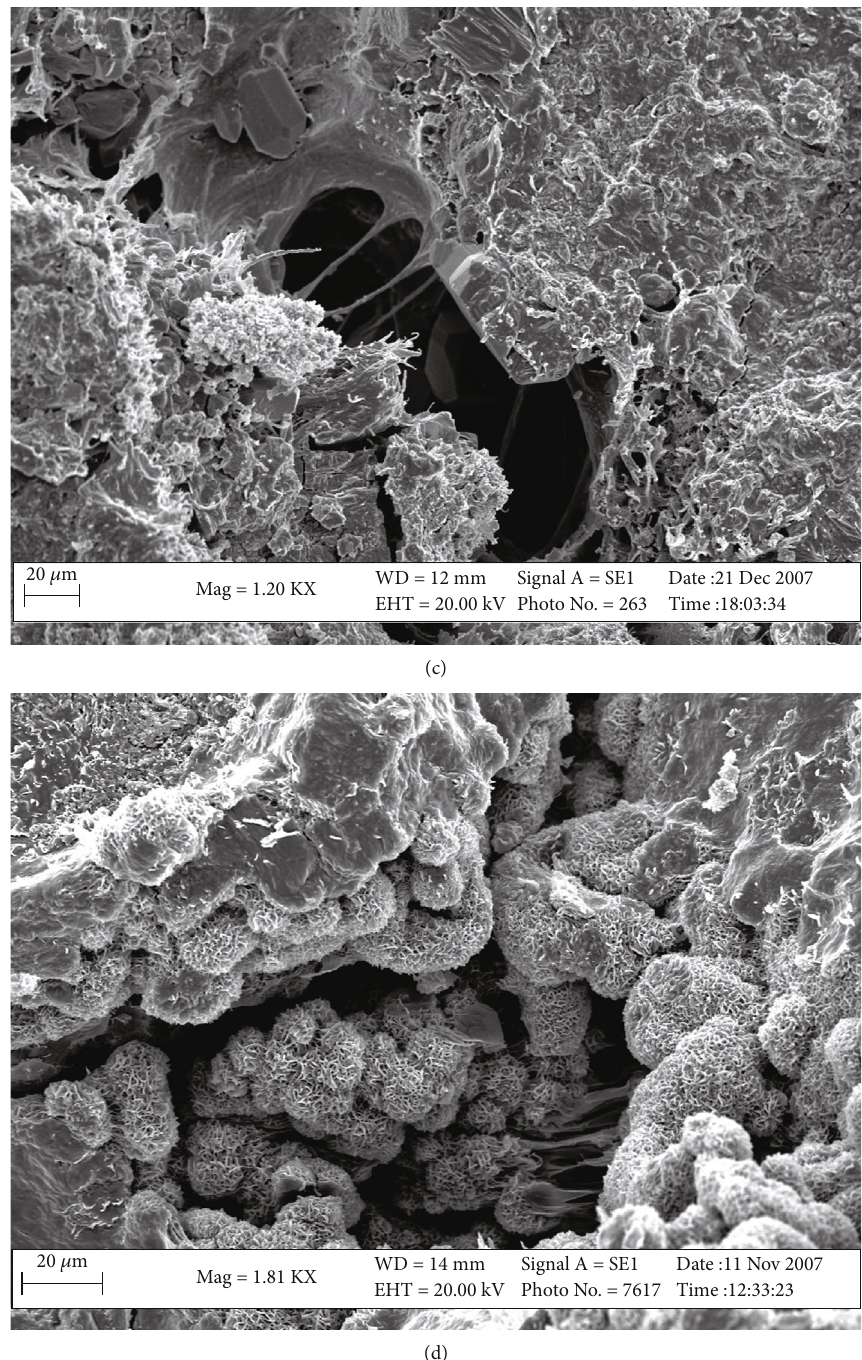
Figure 1: Scanning electron microscope picture of the second Wu member of well 017. (a) W1, 3094.33 m, the intergranular fi lling in illite/montmorillonite mixed-layer minerals; (b) W3, 3361.37m, dissolved pore- fi lled I illite/montmorillonite mixed-layer minerals; (c) W1, 3099.27m, intergranular fi lling of illite/montmorillonite mixed-layer minerals and bridging illite; (d) W3, 3364.67m, intergranular pores and grain-like honeycomb illite/montmorillonite mixed-layer